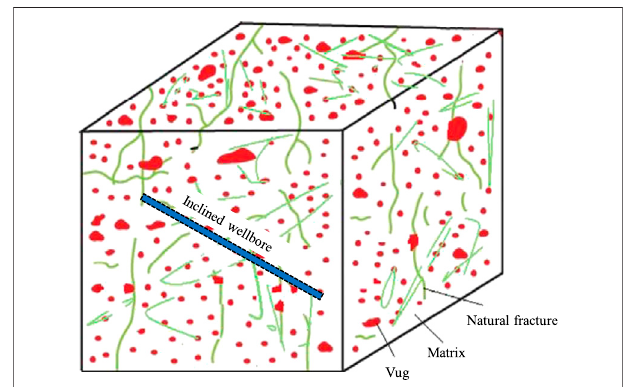
FIGURE 1 | Fractured-vuggy carbonate reservoirs scheme (Modi fi ed after Nie et al., 2012).